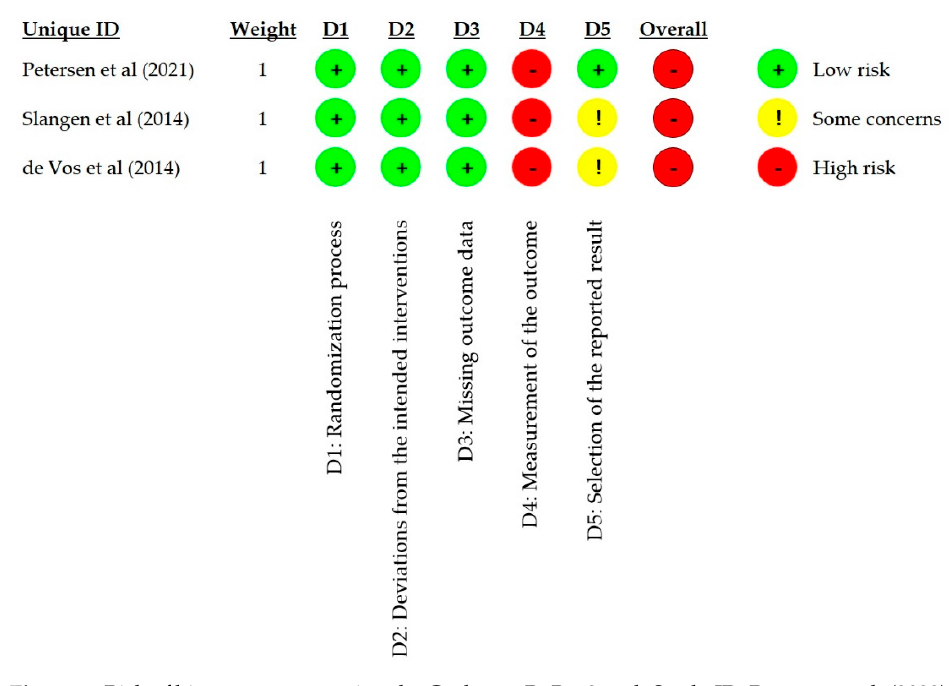
Figure 2. Risk of bias assessment using the Cochrane RoB −− 2 tool. Study ID: Petersen et al. (2022) Slangen et al. (2014) [39], de Vos et al. (2014) [38], Slangen et al. (2014) [39], de Vos et al. (2014) [40].